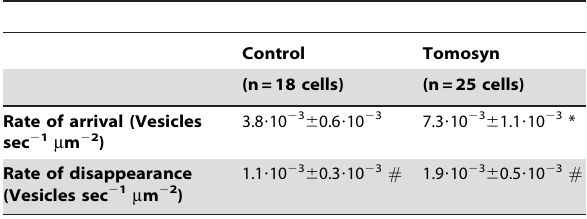
Table 1. Rate of vesicle arrival and disappearance in control and tomosyn overexpressing cells.